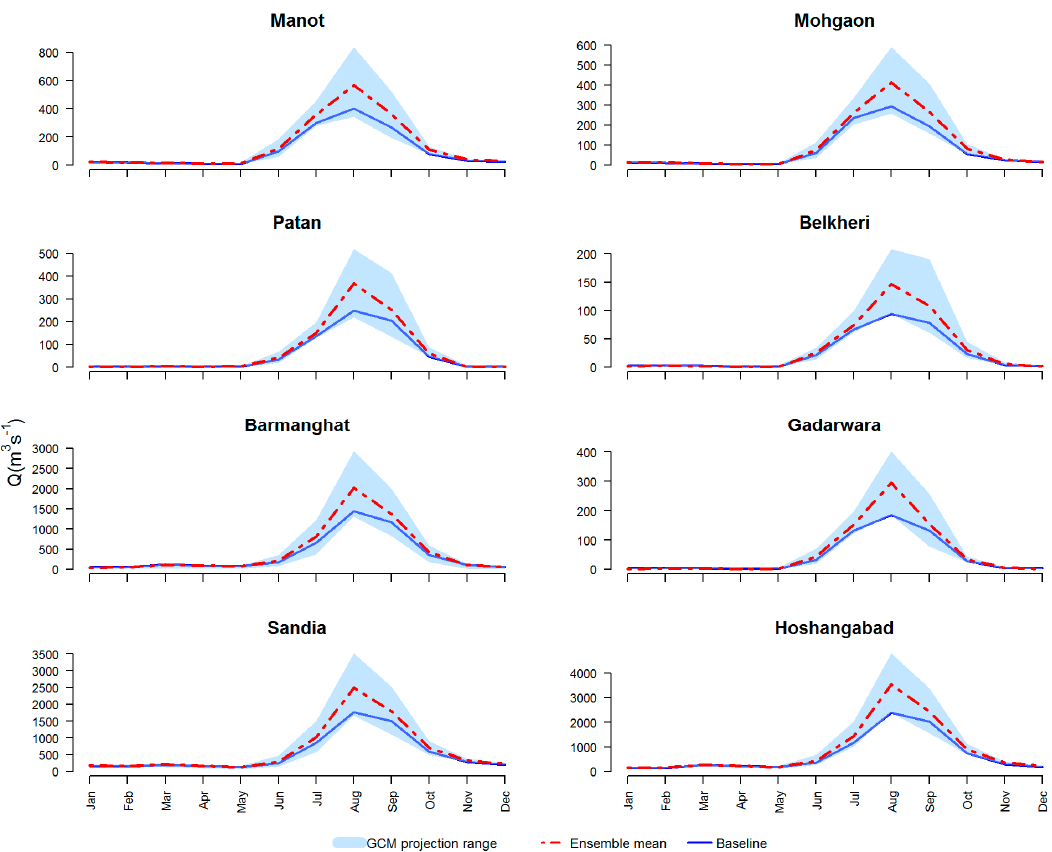
Figure 6. Future monthly flows from seventeen CMIP5 GCM models with ensemble mean (2031–2060), and baseline (1981–2010).